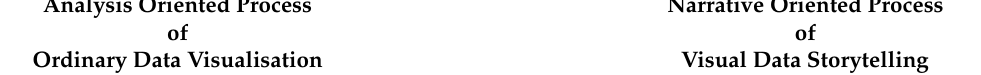
Table 2. Comparing table of regular data visualisation and visual data storytelling.